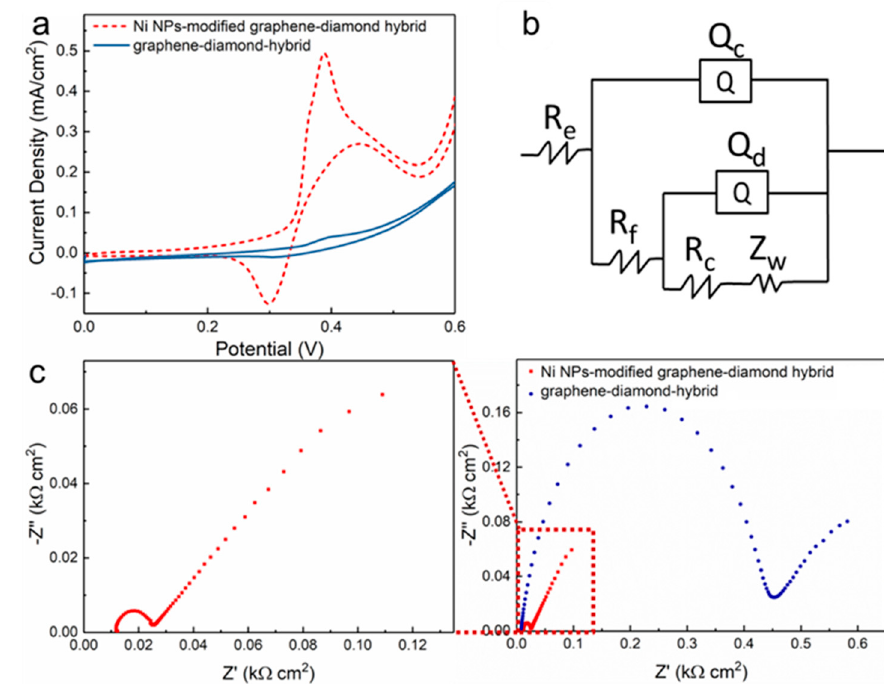
Figure 3. ( a ) Cyclic voltammetry (CV) responses of the graphene–diamond hybrid electrodes with and without Ni NPs modification in 0.5 M NaOH electrolyte containing 5 mM glucose at a scan rate of 20 mV s − 1 . ( b ) An equivalent circuit and ( c ) Nyquist plots of the graphene–diamond hybrid electrodes with and without Ni NPs modification with a frequency between 0.01–100,000 Hz and amplitude of 10 mV. Table 1. The fitting parameters of the fitting equivalent circuit.